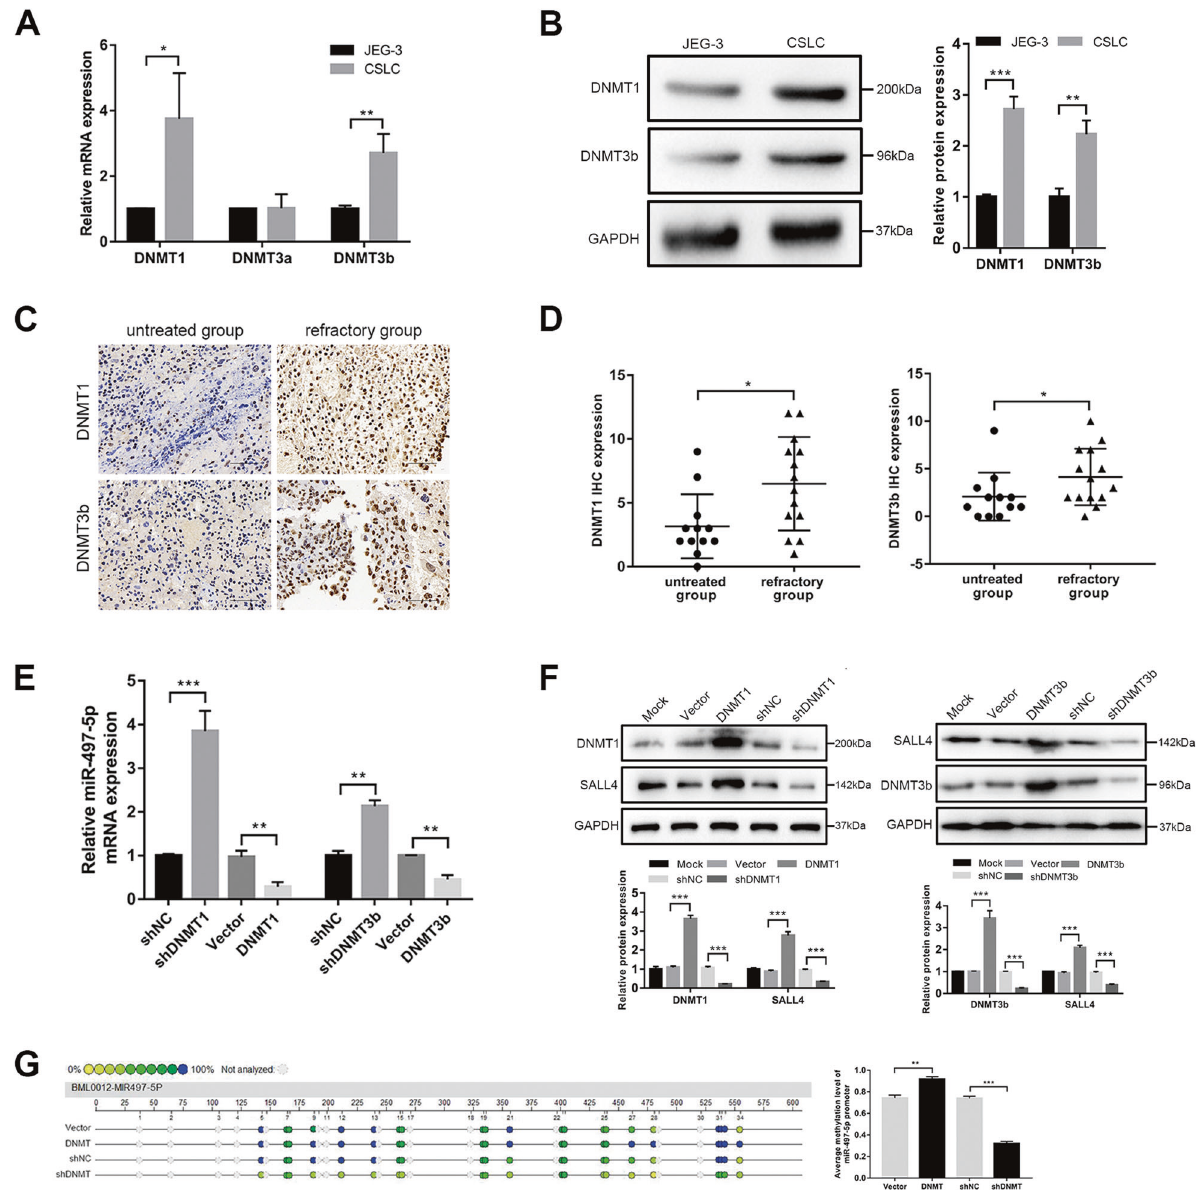
Fig. 6 DNMTs regulate miR-497-5p/SALL4 axis. A qRT-PCR assay for DNMT1, DNMT3a, and DNMT3b levels in JEG-3 cells and CSLCs. B Western blot analysis for DNMT1 and DNMT3b in CSLCs compared with JEG-3 cells. C IHC staining of DNMT1 and DNMT3b in 26 choriocarcinoma tissues (magni fi cations: ×400). D DNMT1 and DNMT3b expression in 14 refractory group compared with 12 untreated group according to IHC scores. E qRT-PCR analysis for miR-497-5p levels in shDNMT1/3b and DNMT1/3b groups compared with control groups in CSLCs. F Respective images (top) of SALL4 levels in shDNMT1/3b and DNMT1/3b groups compared with control groups in CSLCs by western blot analysis and quanti fi cation (bottom). G Pro fi ling of methylation levels of CpG sites in the miR-497-5p upstream region are presented as an epigram (left) and quanti fi cation by average methylation levels (right). Data represent mean ± SD from at least three independent experiments. * P < 0.05, ** P < 0.01, *** P <